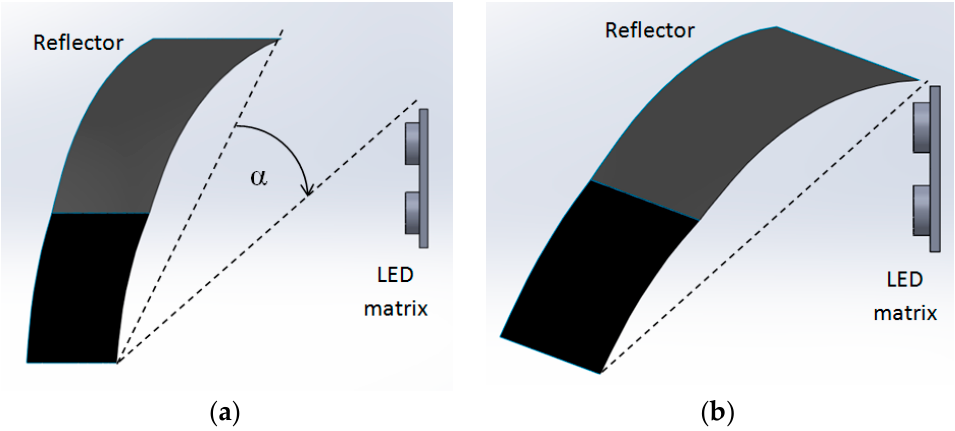
Figure 10. The range of the angular movement of the reflector relative to the LED matrix: ( a ) minimum inclination, ( b ) maximum inclination.